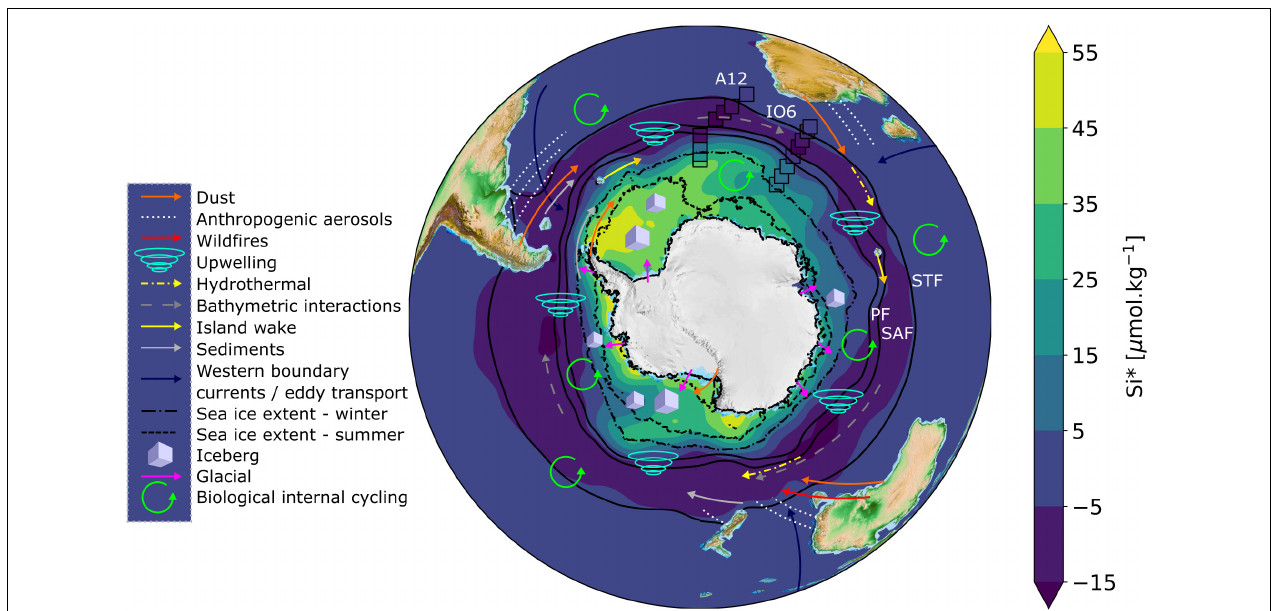
FIGURE 1 | Map of Si ∗ with schematic representations of iron sources overlain. Annual climatological Si ∗ concentrations (=[Si(OH) 4 ] – [NO 3 − ]) for Southern Ocean surface waters (data source: WOA18, 1 degree grid resolution) are overlain by the measured Si ∗ concentrations from A12 2019 and IO6 2017 winter cruises (open black boxes; this study). Solid black contours represent climatological frontal positions based on sea surface temperature; STF = Sub-Tropical Front at 11.5 ◦ C, SAF = Sub-Antarctic Front at 4 ◦ C, PF = Polar Front at 2 ◦ C (Deacon, 1982; Orsi et al., 1995) (data source: WOA18, 1/4 degree resolution). Dashed and dot-dashed black lines represent the mean climatological sea ice extent for summer (Dec/Jan/Feb) and winter (July/Aug/Sep), respectively, defined as 15% sea ice concentration (data source: NSIDC, 12.5 km resolution, Stroeve and Meier, 2018). Iron sources are represented according to the legend, and summarised in Table 1 . The exact locations of some iron sources (e.g., hydrothermal vents, bathymetric interactions) are not well-defined, but are depicted schematically. The important processes of deep winter mixing and vertical diffusion occur throughout the Southern Ocean, but are not depicted. TABLE 1 | Mechanisms of iron supply to the Southern Ocean, with estimates of geographical extent and projected trends under anthropogenic climate change. Mode